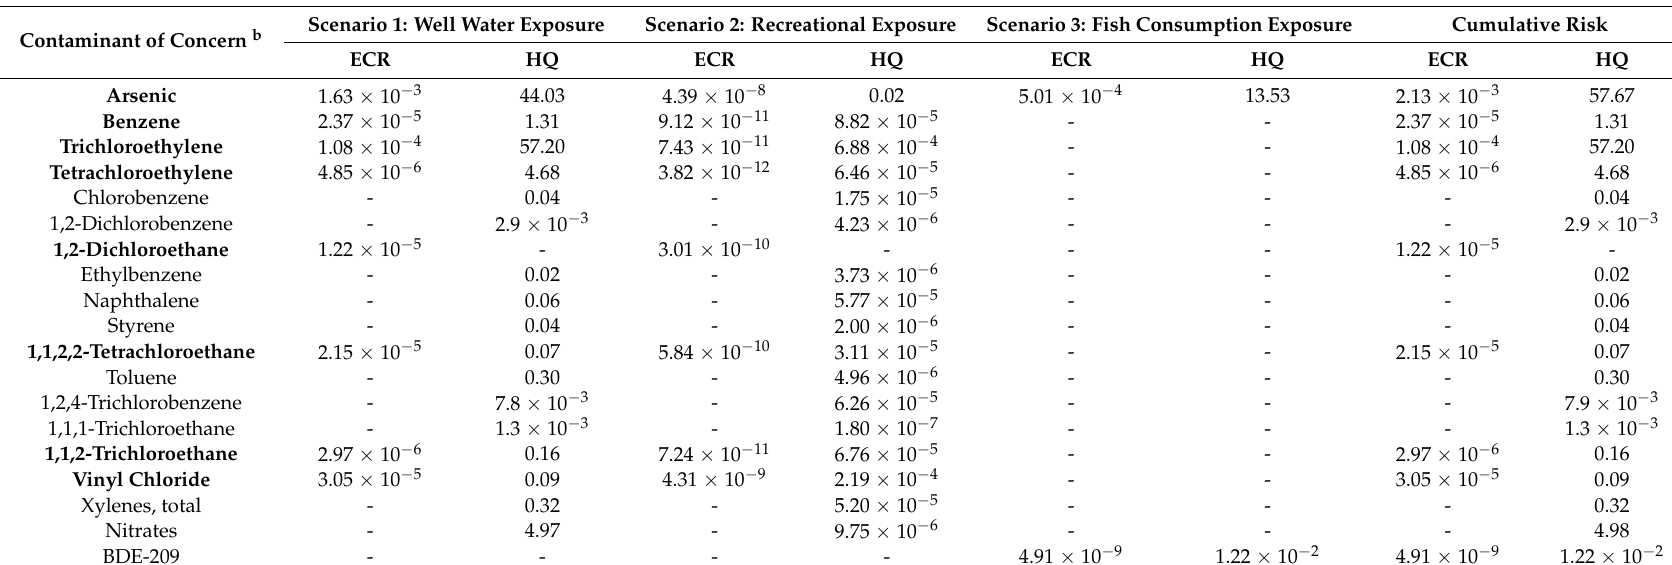
Table 4. Data summary table: results by scenario a